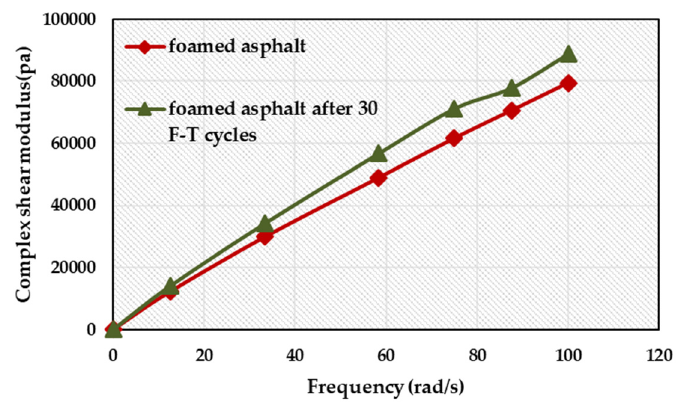
Figure 11. Complex shear modulus of foamed asphalt and foamed asphalt with 30 F–T cycles.